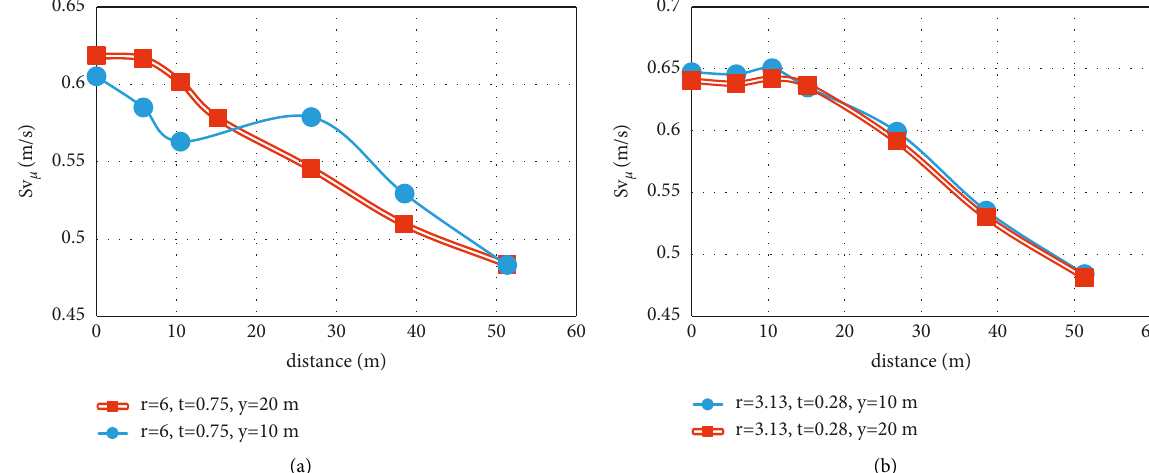
mr=6, t=0.75, y=20 r=6, t=0.75, y=10 Figure 10: The effect of change in overburden depth on ground surface velocity for models (a) 12 and 15 and (b) 16 and 17 of Table